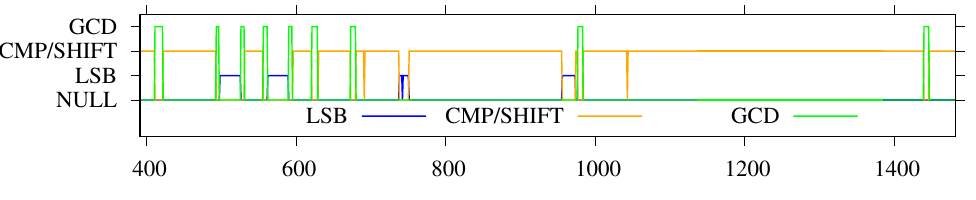
Figure 2: mbedtls_mpi_gcd ACCESSED bit traces of monitored pages (Table